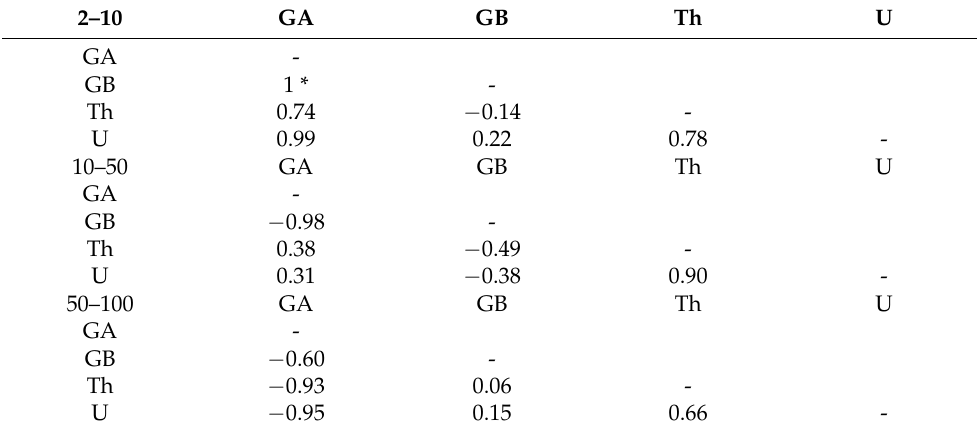
Table 3. Pearson’s correlation between radioactive components of fraction sizes in